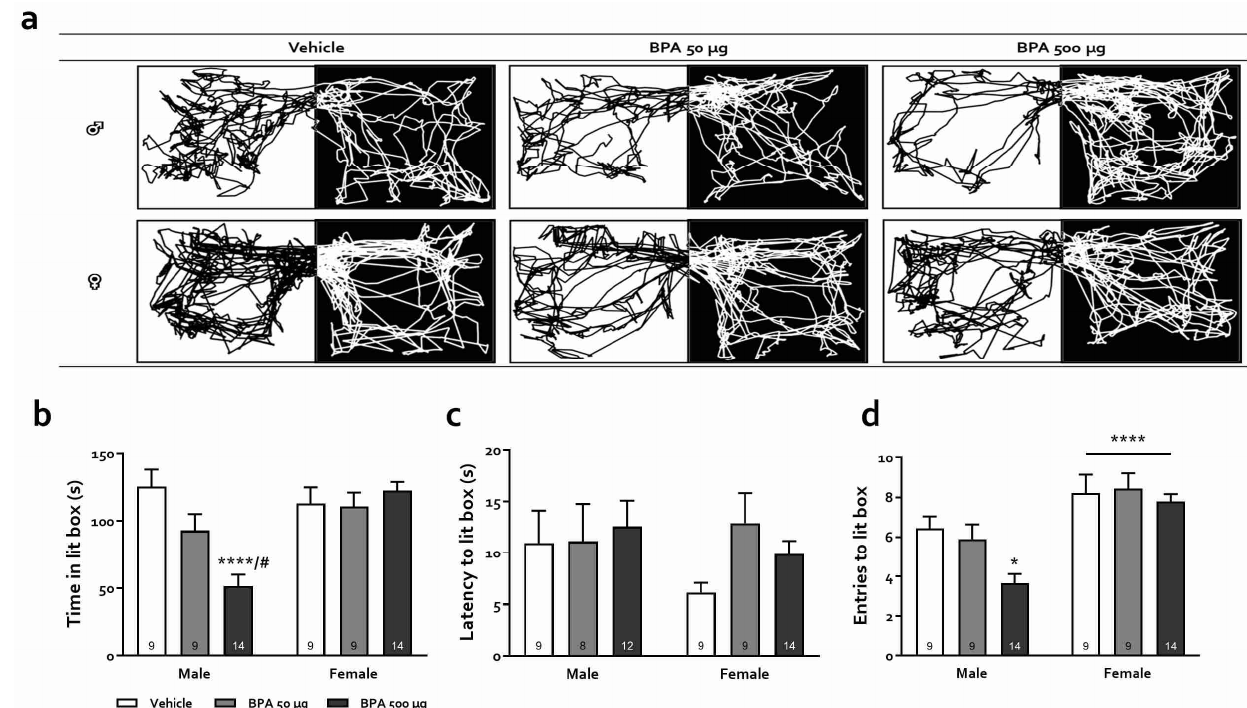
Figure 5. Effects of BPA on LDBT. ( a ) Representative trajectory for each treatment. The black area corresponds to the dark box and the white one to the light box; ( b ) Time spent in the light box for male and female rats; ( c ) Latency to enter the light box. ( d ) Number of transitions to the light box. Results are expressed as mean ± SEM. Numbers within bars indicate animals per group. ****: p < 0.0001 vs. male vehicle group; #: p < 0.05 vs. male 50 µ g group; *: p < 0.05 vs. male vehicle group; ****: p < 0.0001 male vs. females.